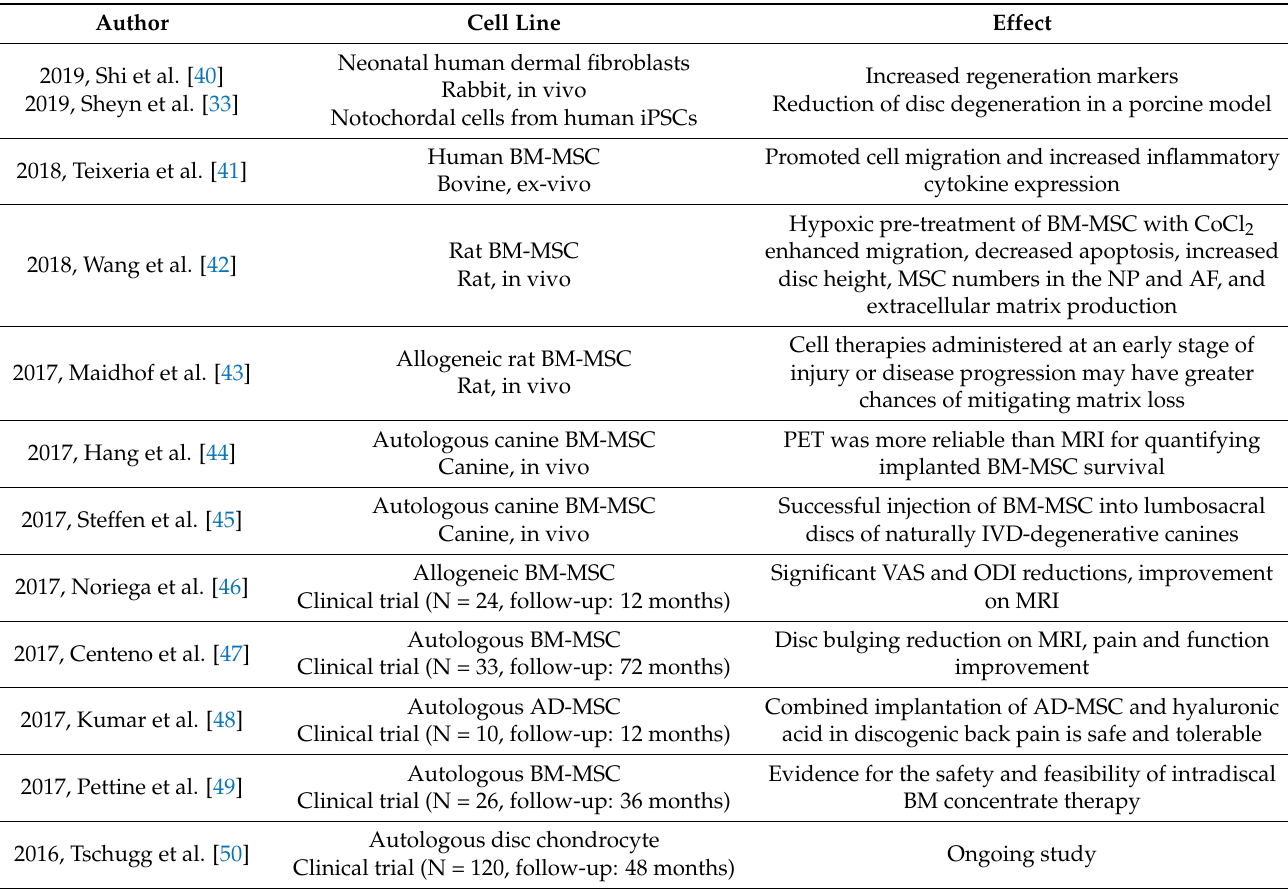
Table 1. Cell-based therapies for IVD